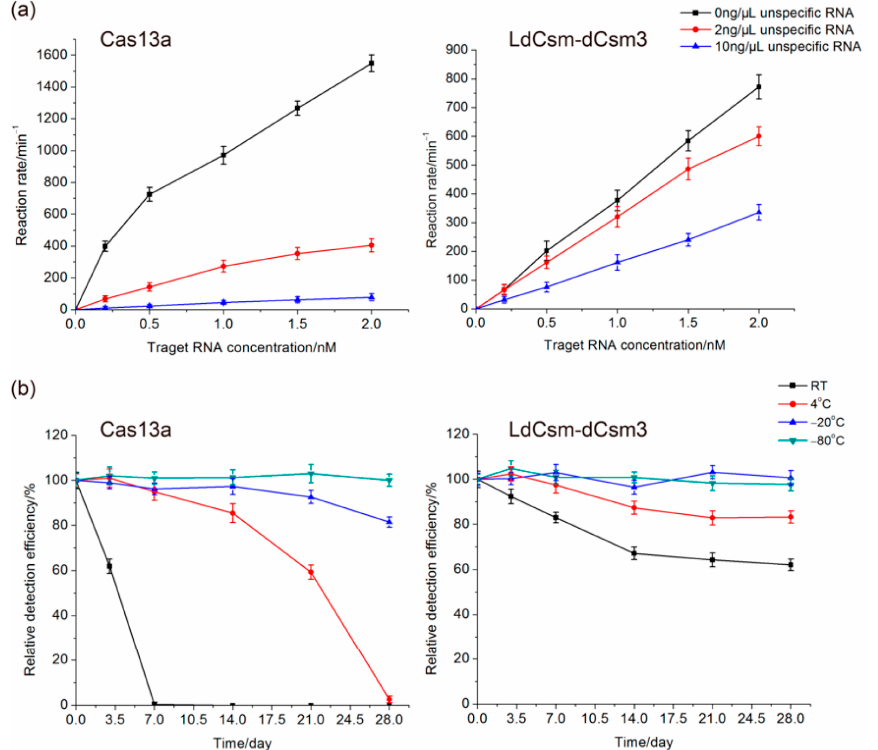
Figure 4. Comparison of the LwaCas13 and LdCsm-dCsm3 detection systems. ( a ) Influence of unspecific RNAs. ( b ) Influence of storage conditions. Detection efficiency of Cas13a or LdCsm- dCsm3 stored for 0 days was set as 100% each. The detection assay was set up with 100 nM Cas enzymes (Cas13a or LdCsm) and 10 µ M RNA/DNA reporter. Unspecific RNAs were total RNAs prepared from E. coli BL21 (DE3)